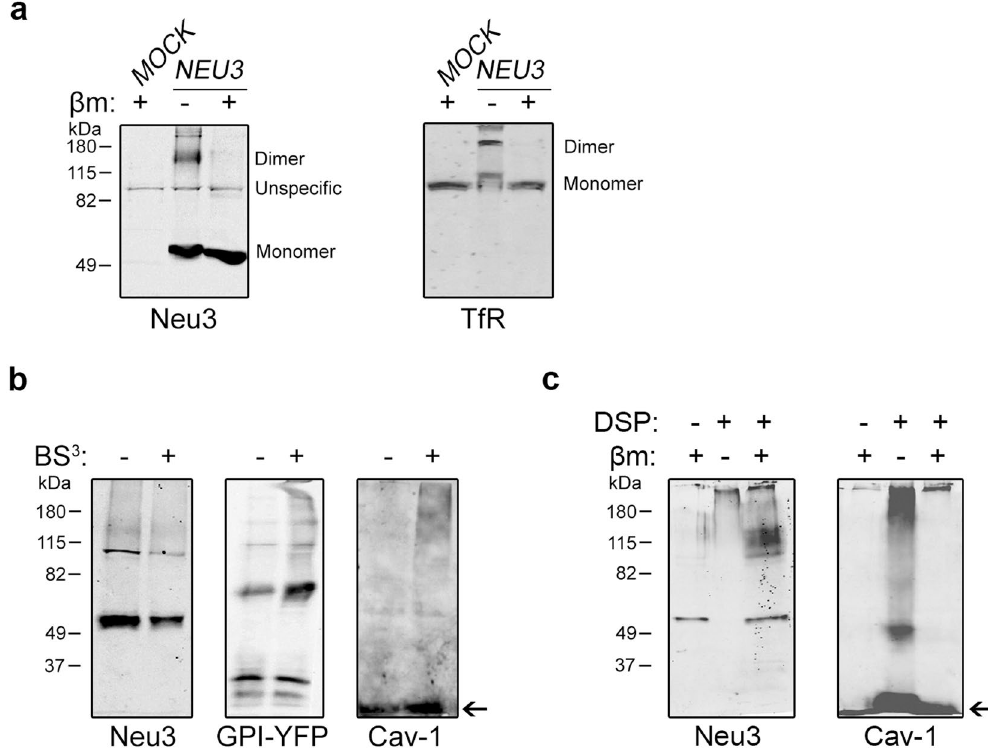
Figure 5. Neu3 interacts with itself via disulfide bridges and with other proteins. ( a ) Total homogenates of MOCK - and NEU3 -transfected cells were separated by SDS-PAGE with ( + ) or without ( − ) 5% β -mercaptoethanol ( β m), and Western blotted with antibody against Neu3 and antibody against endogenous TfR. ( b ) NEU3 -transfected cells were subjected to chemical cross-linking with ( + ) or without ( − ) the membrane-impermeable reagent BS 3 . Then, proteins were separated by SDS-PAGE and detected by Western blotting using anti-Neu3 antibody. Cav-1 (indicated by an arrow) and GPI-YFP were used as markers of proteins not accessible and accessible to BS 3 , respectively. ( c ) NEU3 -transfected cells were subjected to chemical cross-linking with ( + ) or without ( − ) the membrane-permeable reagent DSP. Then, proteins were separated by SDS-PAGE, and detected by Western blotting using anti-Neu3 antibody. Cav-1 (indicated by an arrow) was used as marker of a protein accessible to DSP. Due to the presence of a disulfide bridge in DSP molecule, the crosslinking can be reversed by the addition of β m. The molecular masses in kDa of the standard proteins are shown on the